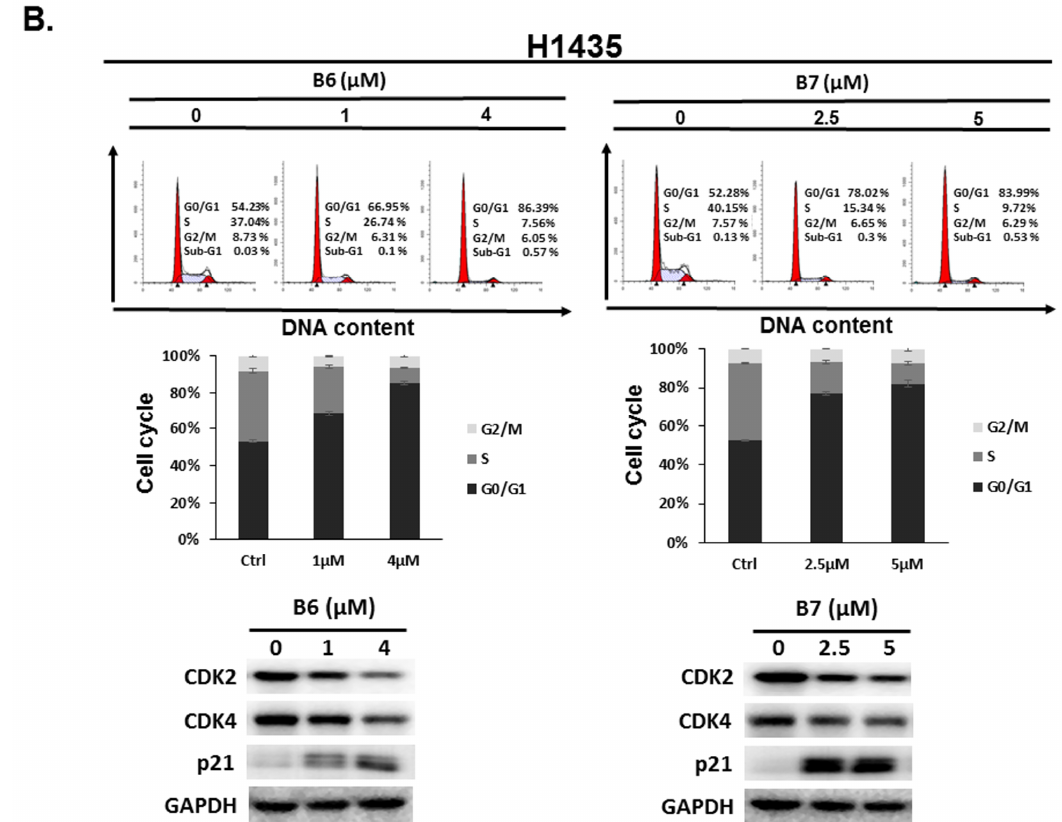
Figure 4. Cell cycle profile for in non-small-cell lung cancer cells after incubation with B6 and B7. ( A ) A549 and ( B ) H1435 cells were incubated with control medium or B6 and B7 for 24 h, and the cell cycle was examined with FACS flow cytometry. Additionally, the total cell lysate was isolated and the expressions of CDK2, CDK4, and p21 were verified with western blotting. DMSO was used as a negative control. GAPDH was used as a loading control. Three independent experiments were conducted.